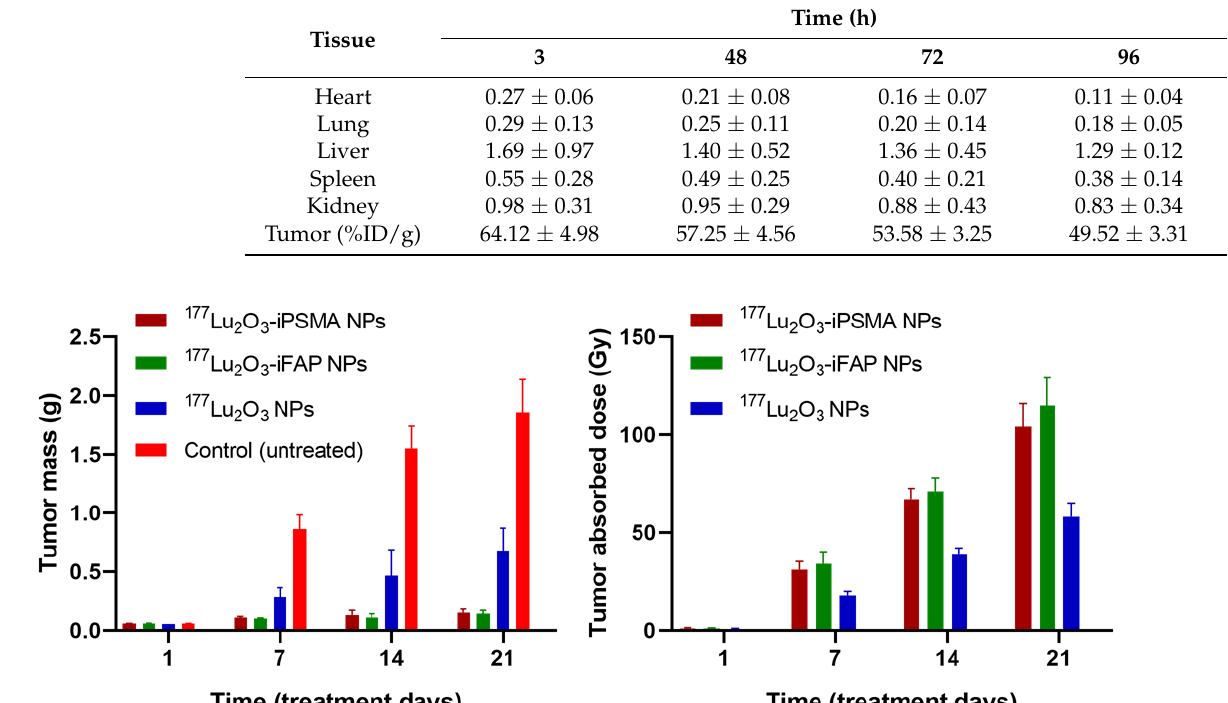
Table 5. Biodistribution (% injected dose) at various time points of 177 Lu 2 O 3 in nude mice bearing HCT116 tumors (mean ± SD) ( n = 3), after intratumoral injection.